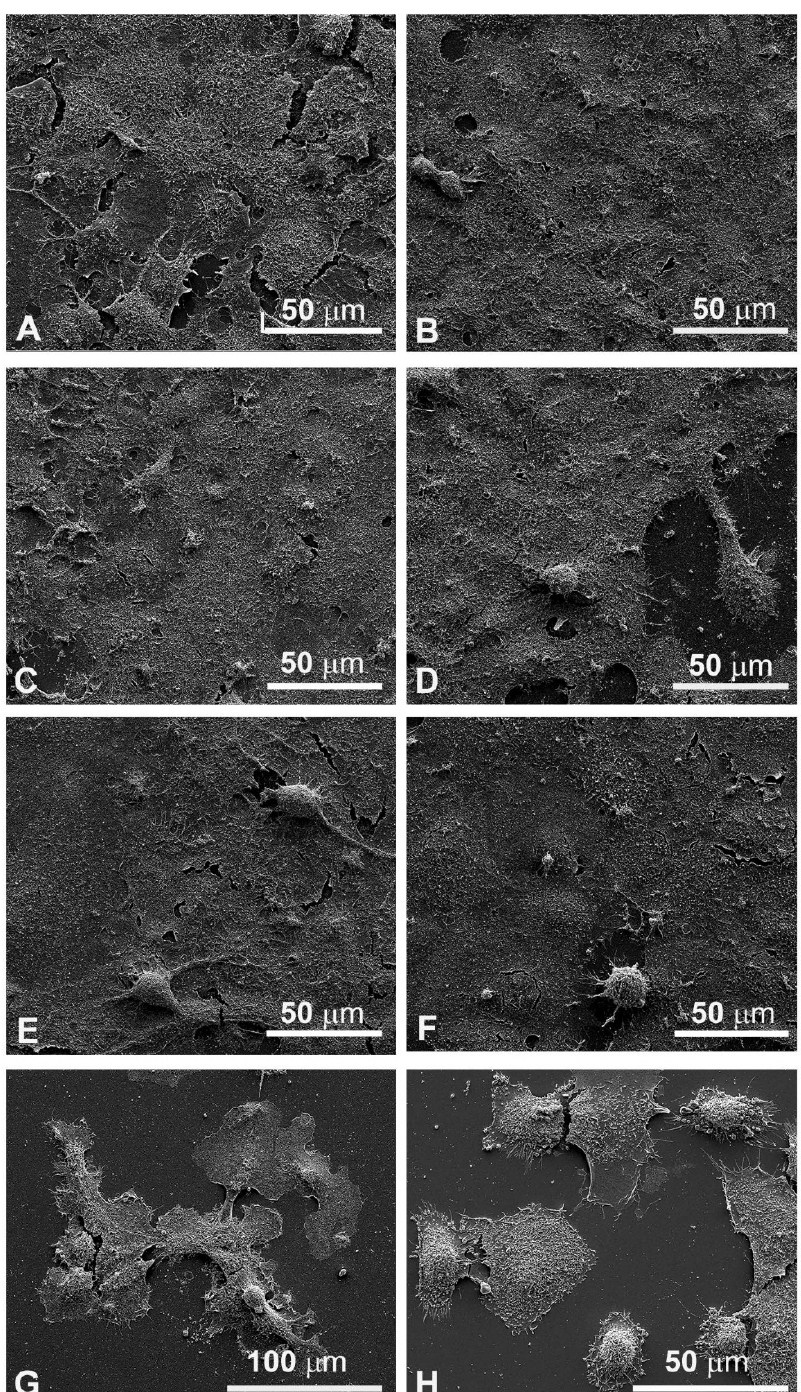
Figure 5. Scanning electron microscopy observations of FaDu cells (left panel) and CAL 27 cells (right panel) for 24 h after treatment. ( A , B ) Control, no treatment; ( C , D ) single EP; ( E , F ) MMC (5 µM); ( G , H ) combined treatment (EP+MMC).